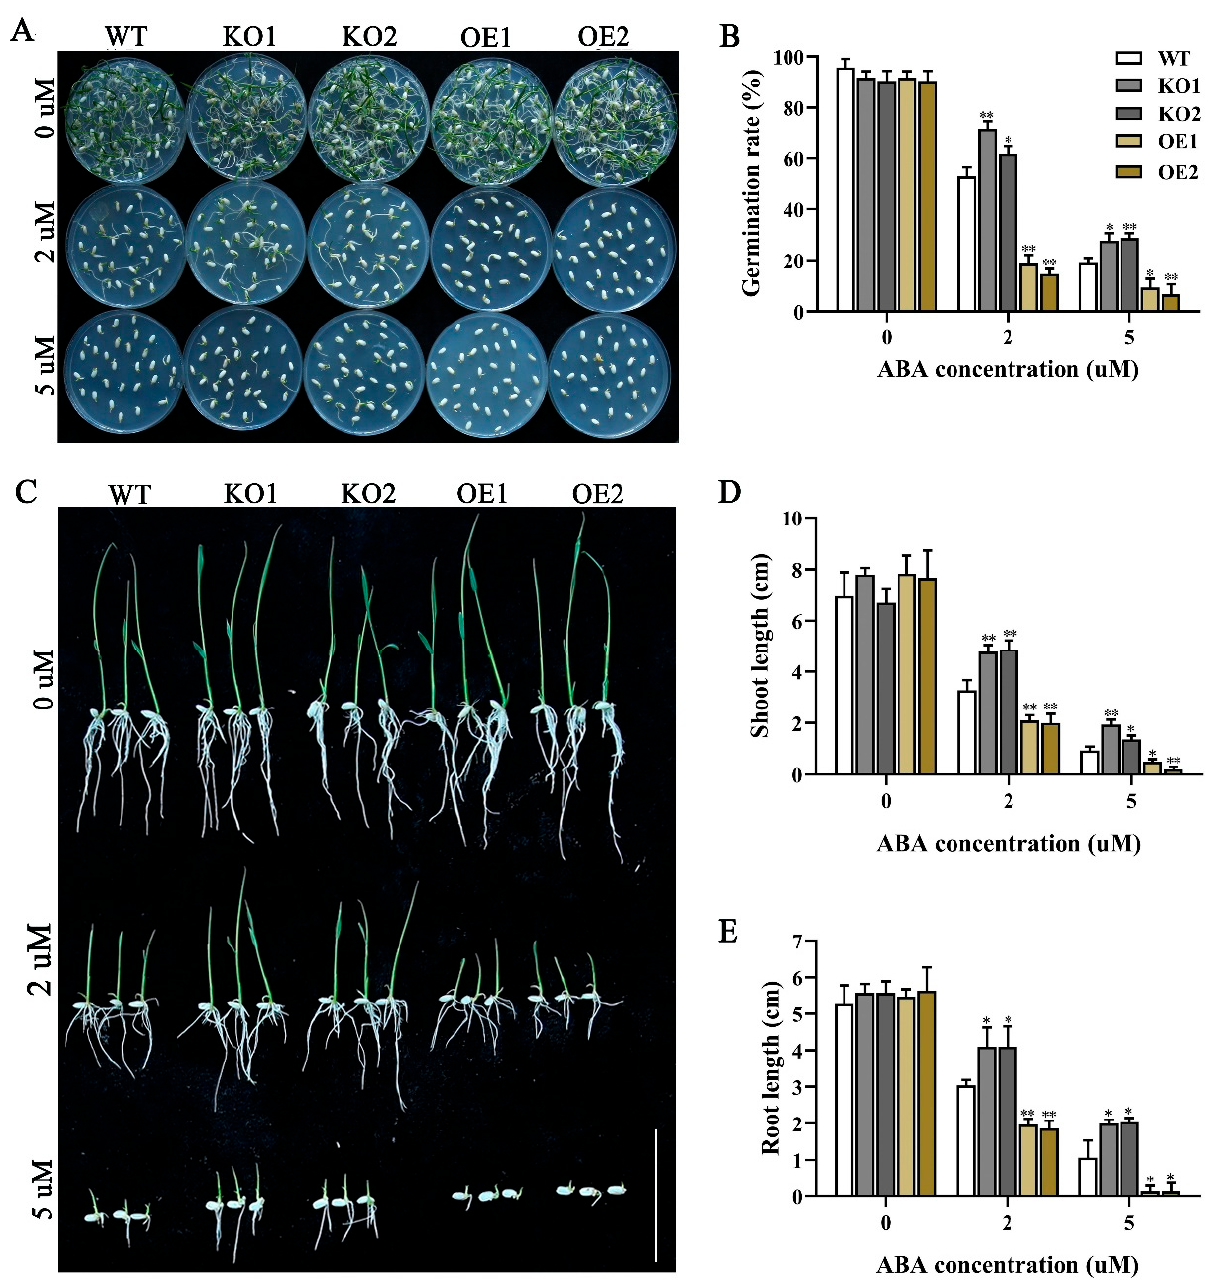
Figure 5. Germination of WT, KO1, KO2, OE1, and OE2 seeds in the ABA treatment. ( A ) Germination of OE1 and OE2 seeds treated with 0, 2, and 5 µ M ABA for 5 days. ( B ) Germination rates of WT, KO, and OE seeds on 1/2 MS medium containing 0, 2, and 5 µ M ABA. ( C ) Growth of WT, KO, and OE plants treated with 0, 2, and 5 µ M ABA after seed germination on 1/2 MS medium for 2 days. Scale bar = 2 cm. ( D , E ) Shoot length ( D ) and root length of WT, KO, and OE plants. Data represent the mean ± SD of three independent replicates. Asterisks indicate statistically significant differences (* p < 0.05, ** p < 0.01).